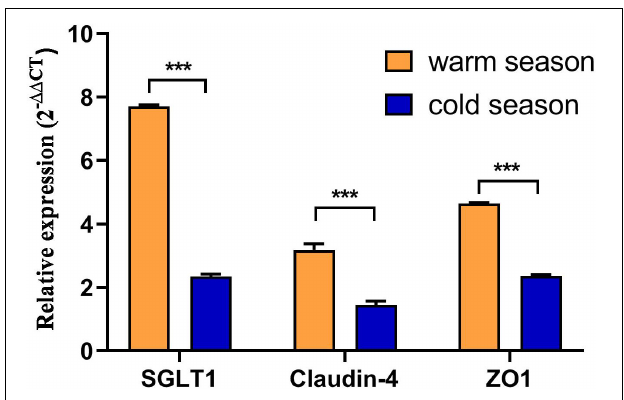
FIGURE 5 | Nutrient absorption and barrier function related gene expression. *** P <